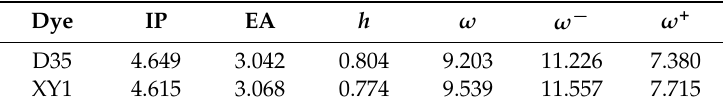
Table 1. Chemical reactivity (in eV) of D35 and XY1 in acetonitrile solution; IP (Ionization Potential); EA (the Electron